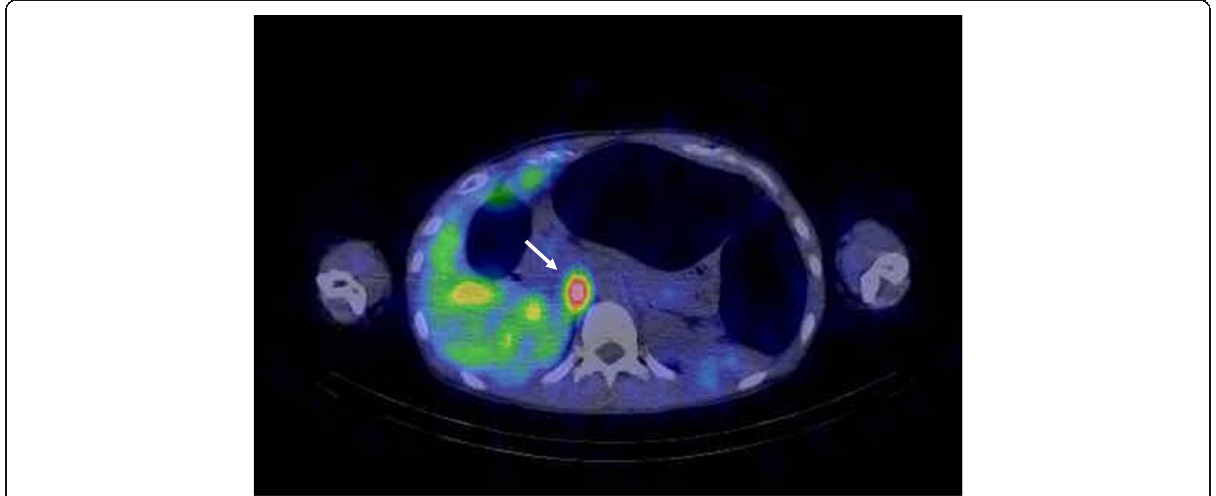
Fig. 1 123 I-metaiodobenzylguanidine scintigraphy shows a 17 × 15 mm mass accumulation on the left of the inferior vena cava (white